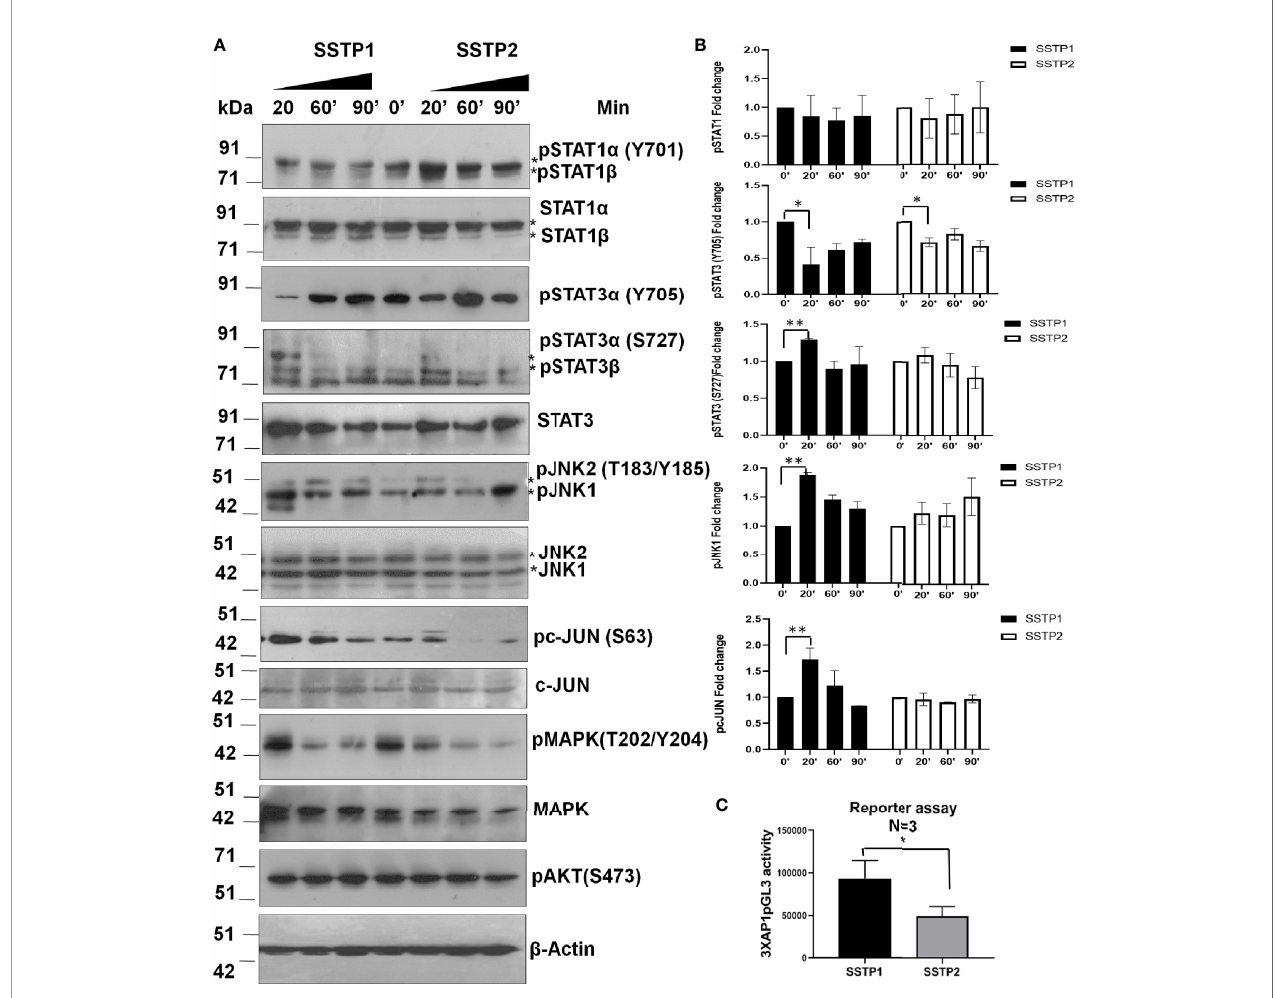
FIGURE 7 | SSTP1 preferentially activates JNK/AP1 pathway (A) HSC-4 cells were treated with the peptides as indicated before for the indicated time points, and the lysates were used for western blot. (B) Densitometric analysis was performed and relative phosphorylation of each molecule was calculated. Fold change based on untreated from biological duplicates were plotted. (C) A luciferase reporter assay was performed using 3×AP1pGL3 reporter construct after treatment with the peptides (10 m M) for 48h. The beetle luciferase activity was normalized with renilla luciferase activity. *p < .05, **p <